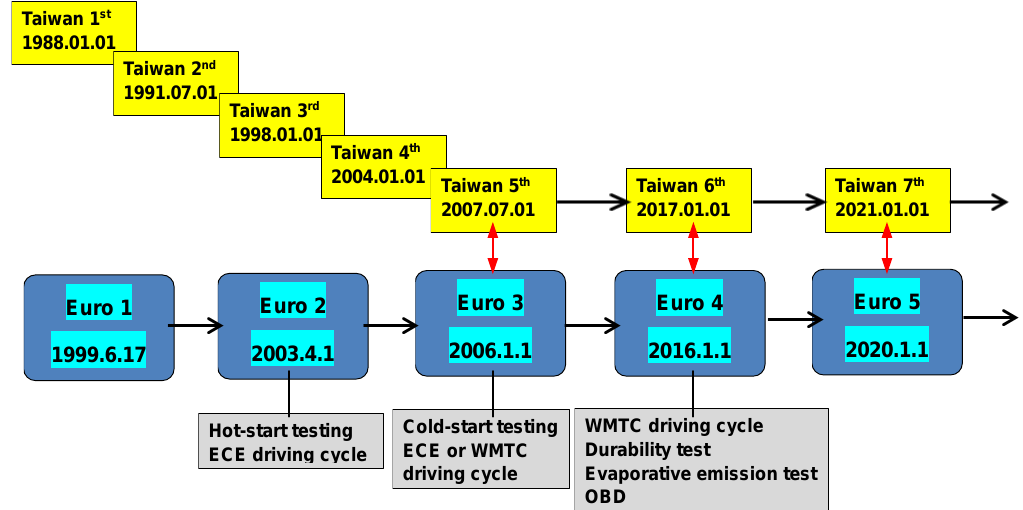
Figure 1. Evolution of motorcycle emission regulations by the ECE and Taiwan (WMTC: worldwide motorcycle test cycle; OBD: on-board diagnostics).